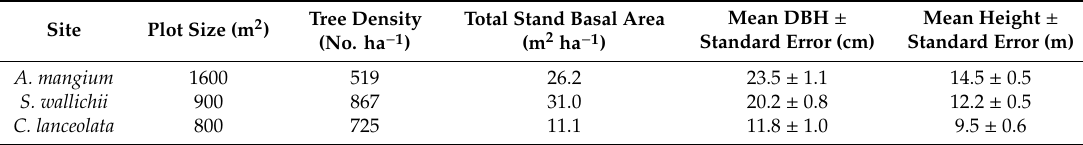
Table 1. Site characteristics of three sites.